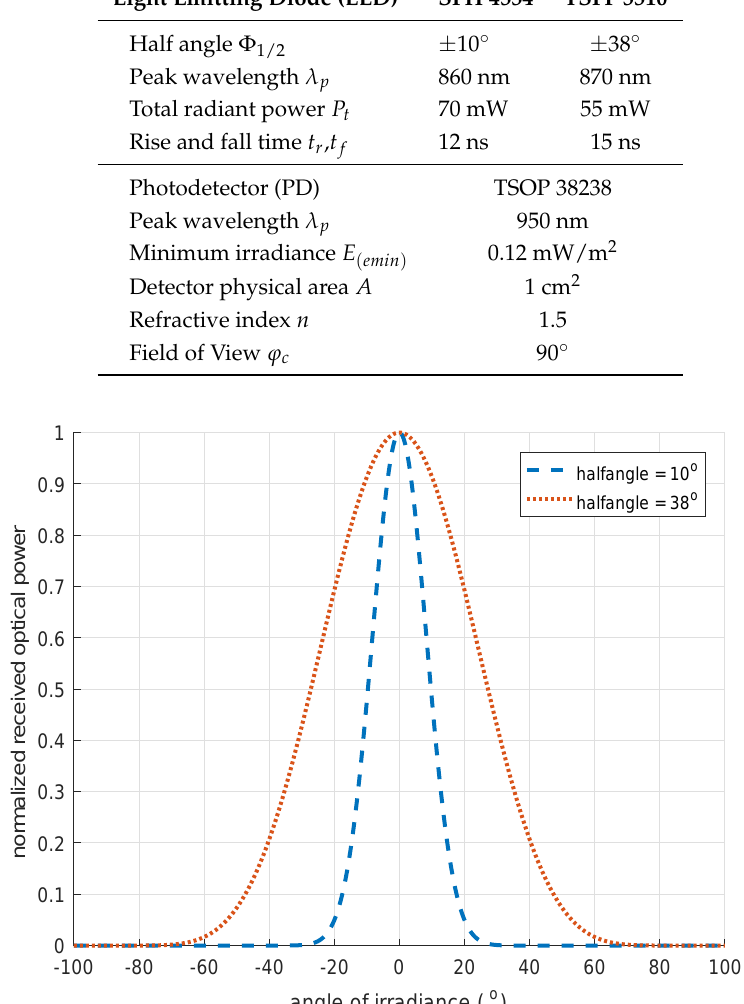
Figure 3. Normalized received optical power for LEDs with a half angle of 10 and 38 ◦ and a horizontally moving receiver on a plane at a distance 3 m from the